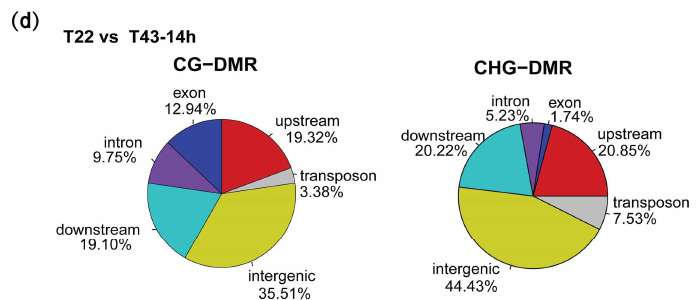
Figure 5. Global analysis of DMRs. ( a ) Total number of DMRs and the distribution of hyperDMRs and hypoDMRs comparing T43-4h to T22 (T22 vs. T43-4h); ( b ) CG, CHG and CHH context DMRs mapping to the different genomic categories of T22 vs. T43-4h; ( c ) total number of DMRs and distribution of hyperDMRs and hypoDMRs comparing the T43-14h to the T22 group (T22 vs. T43-14h); ( d ) CG, CHG and CHH context DMRs mapping to the different genomic categories of T22 vs. T43-14h.